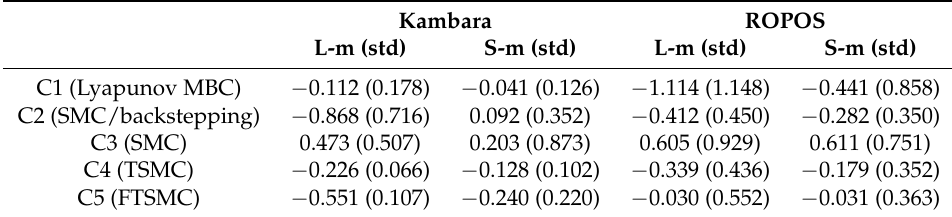
Table 2. Means (m) and standard deviations (std) of tracking errors.